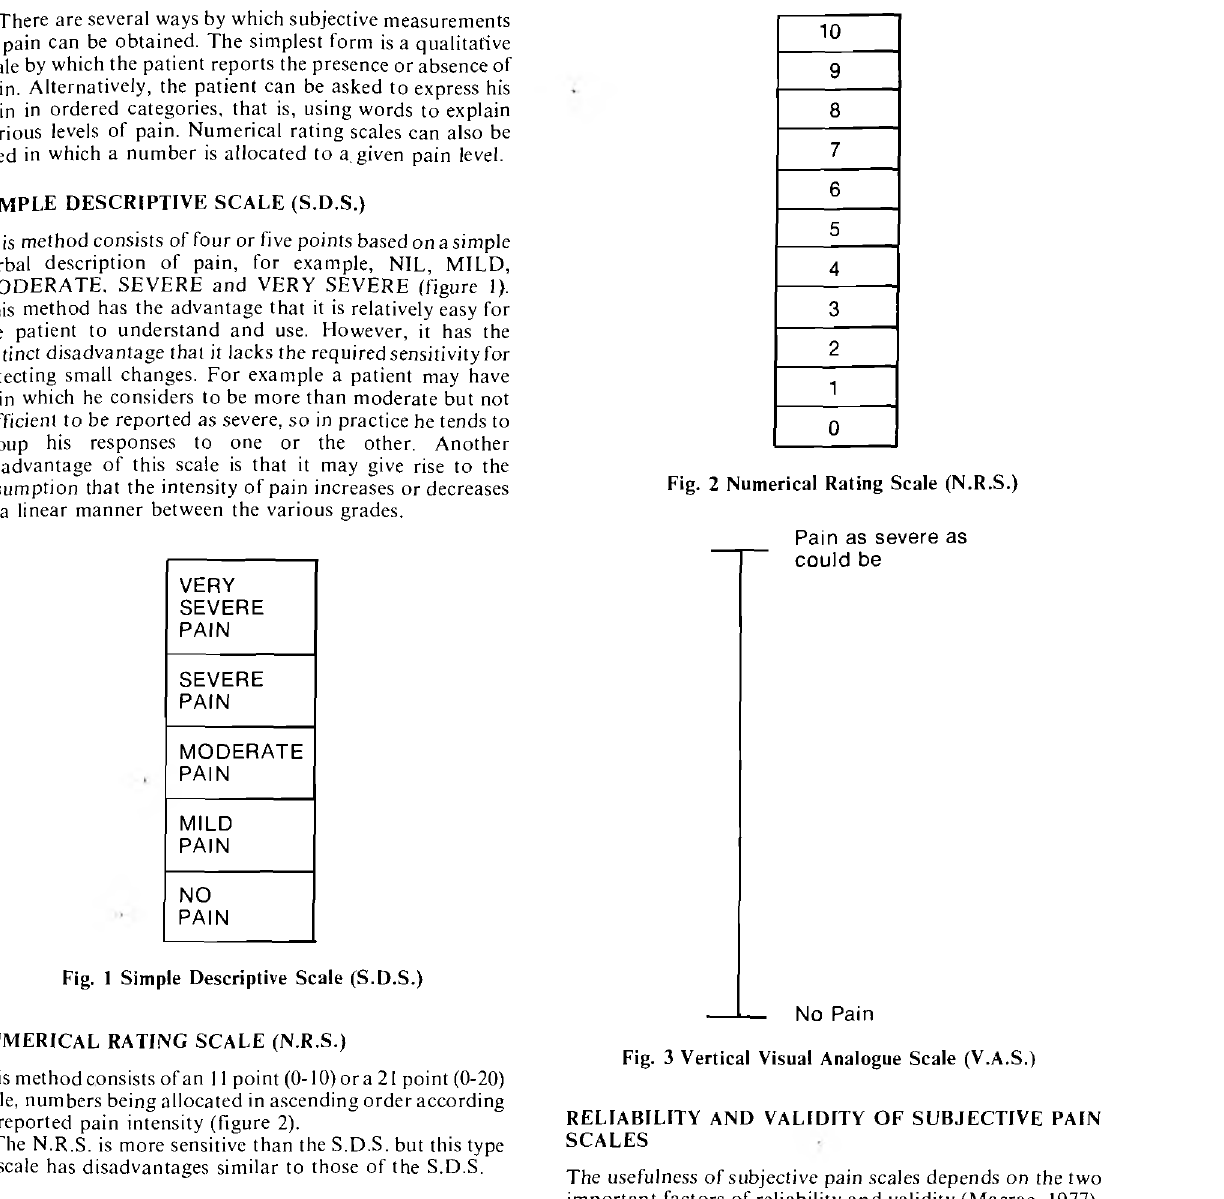
Fig. 1 Simple Descriptive Scale (S.D.S.)